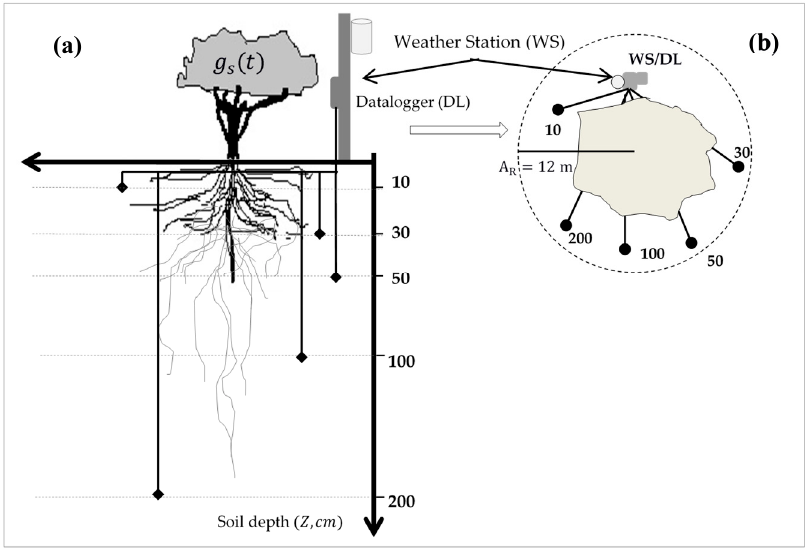
Figure 2. ( a ) Instrument set-up to measure atmospheric variables and soil volumetric water content at different soil depths. ( b ) A R indicates the area within which soil sensors were installed.